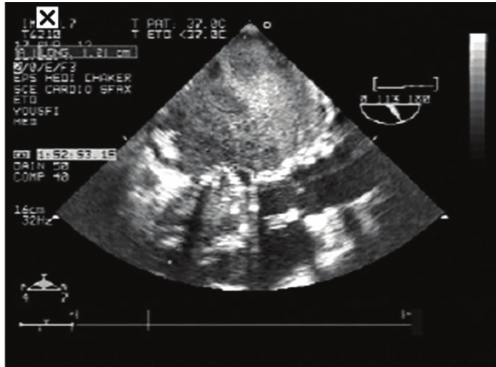
Figure 2: Transesophageal echocardiography (TEE) revealed vege- tation on the anterior mitral annulus (1.2 ∗ 0.5 cm).